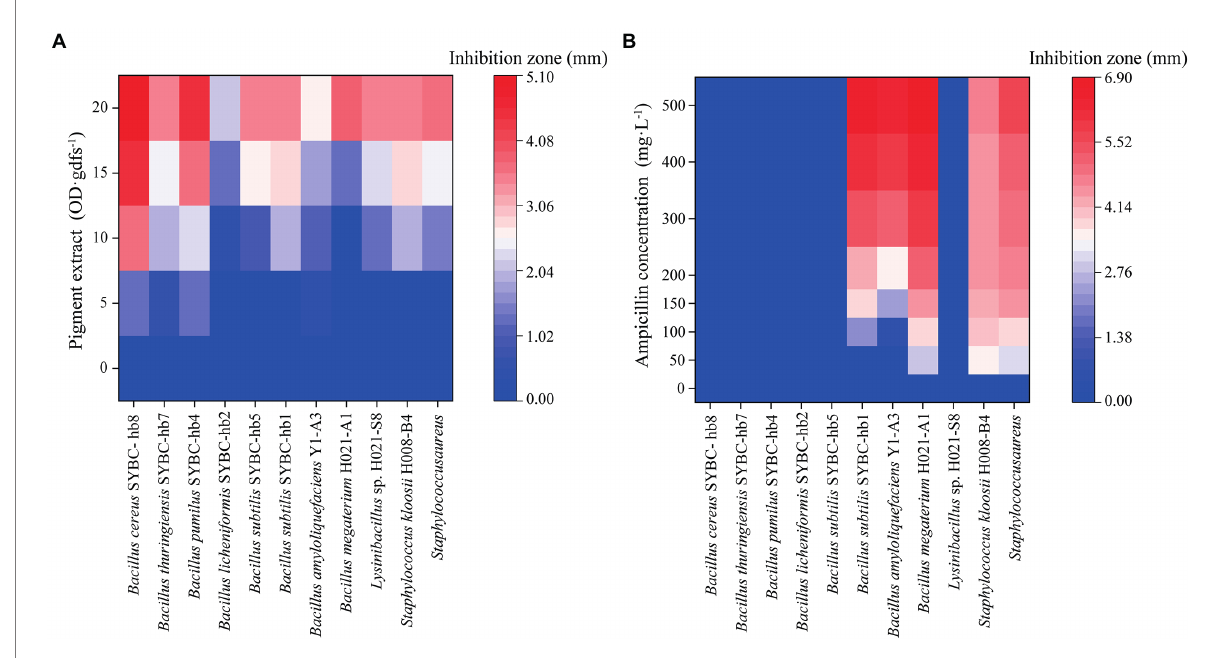
FIGURE 5 Heatmaps of antibacterial activity of pigment extract (A) and ampicillin (B) for Gram-positive bacteria. Data correspond to the mean of three